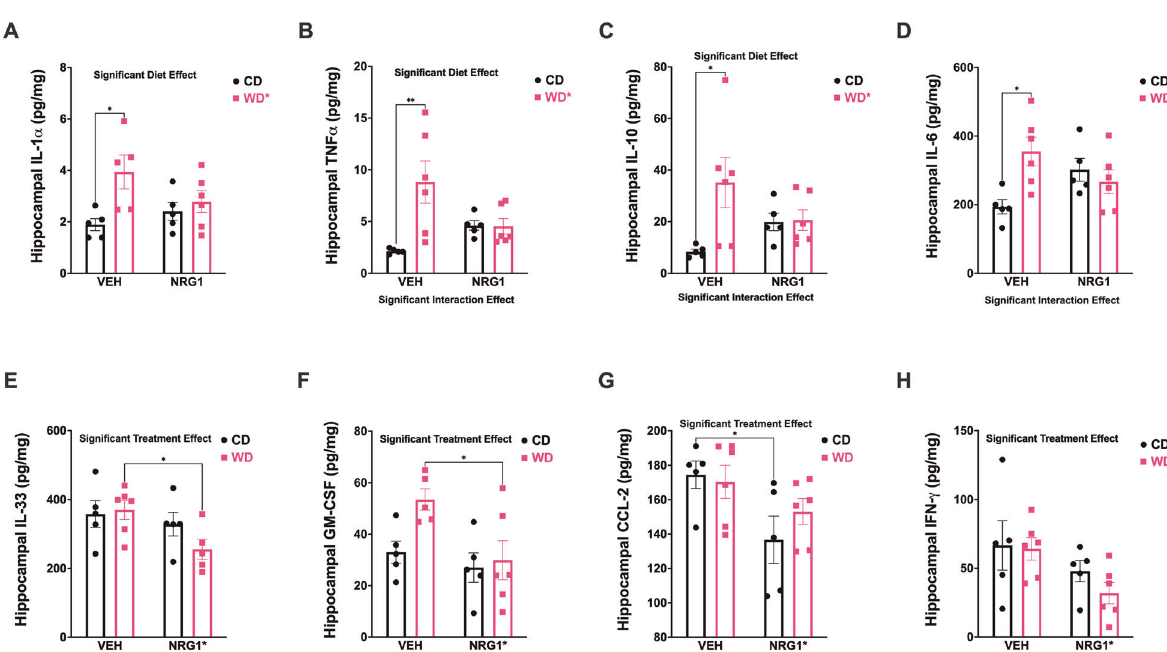
Fig. 5 Obesogenic diet consumption and prolonged NRG1 injections alter selective in fl ammatory mediators in the rat hippocampus. Bead-based fl ow cytometry immunoassay was used to evaluate cytokine levels. A – D The WD led to a signi fi cant increase in cytokines in the hippocampus: IL1- α ( p = 0.010), TNF- α ( p = 0.006), IL-10 ( p = 0.027), and IL-6 ( p = 0.019). E – H NRG1 administration signi fi cantly reduced IL-33 ( p = 0.041), GM-CSF ( p = 0.021), CCL-2 ( p = 0.037), and IFN- γ ( p = 0.031). Supplemental Table 3 includes the detailed statistics of the cytokines listed in Fig. 5. Sample size = 5 – 6 rats/group. Sample numbers: CD + VEH, n = 6; CD + NRG1, n = 6; WD + VEH, n = 6; WD + NRG1, n =